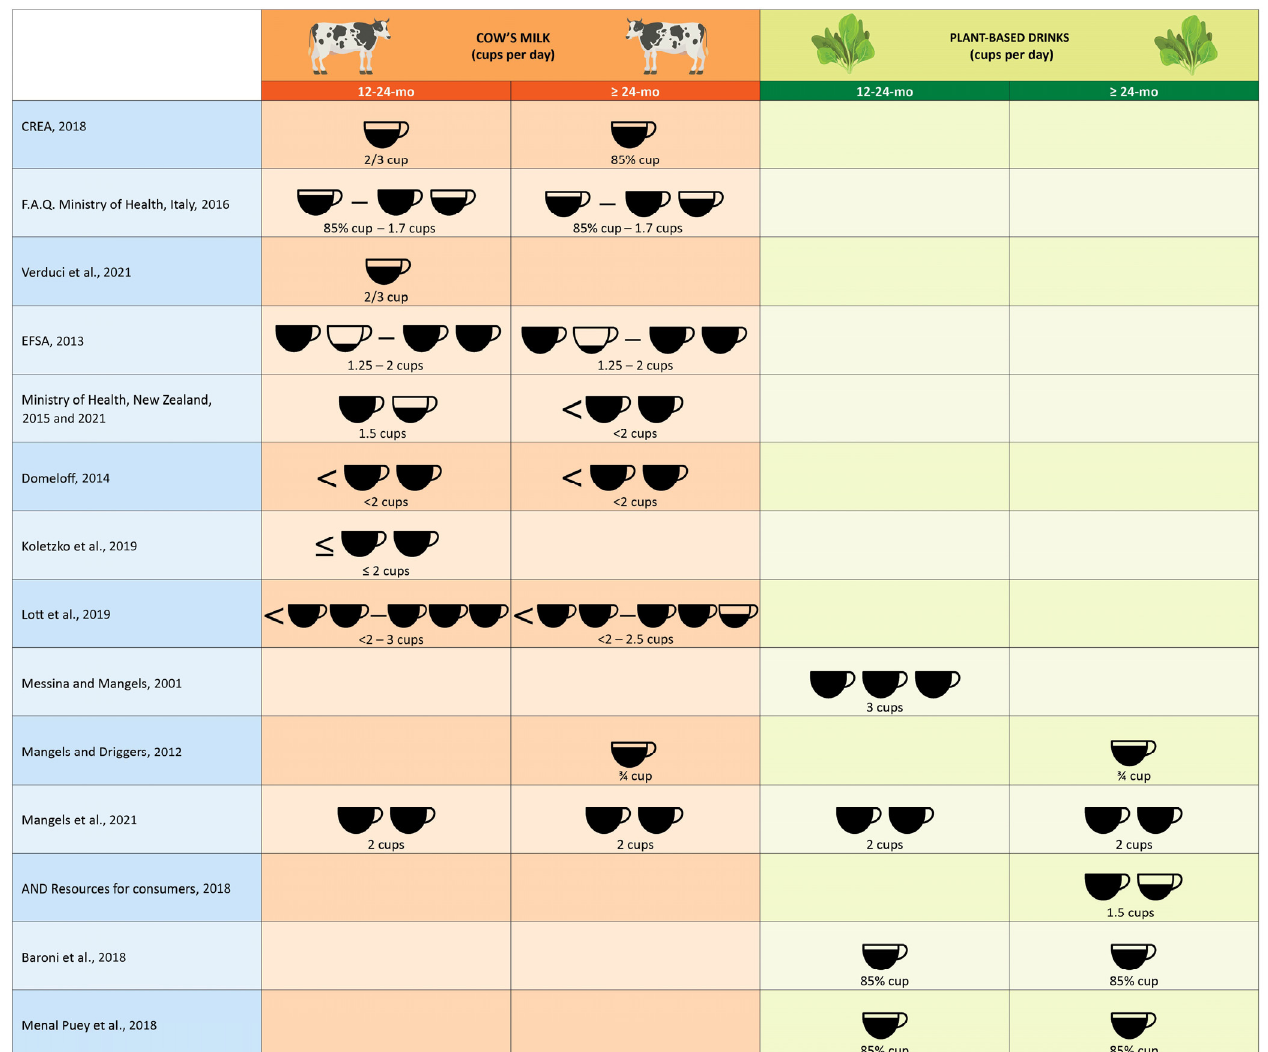
Figure 1. Graphical representation of the suggested amount of cow’s milk and plant-based drinks for children aged 12 to 24 months and from 24 months of age onward, according to the selected literature - see text for details (1 cup = 236 mL) [44,67–69,74,77,78,80–87].